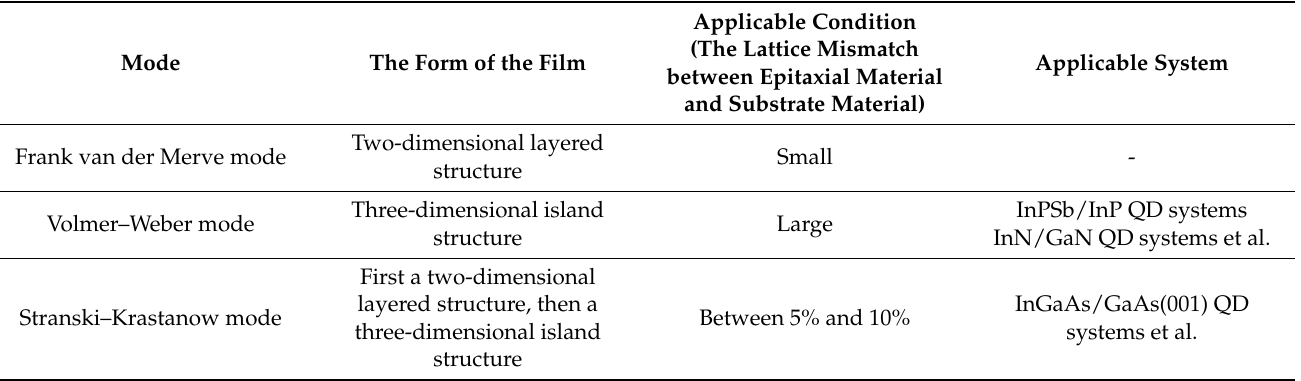
Table 1. Comparison of the Frank van der Merve, Volmer–Weber, and Stranski–Krastanow methods.